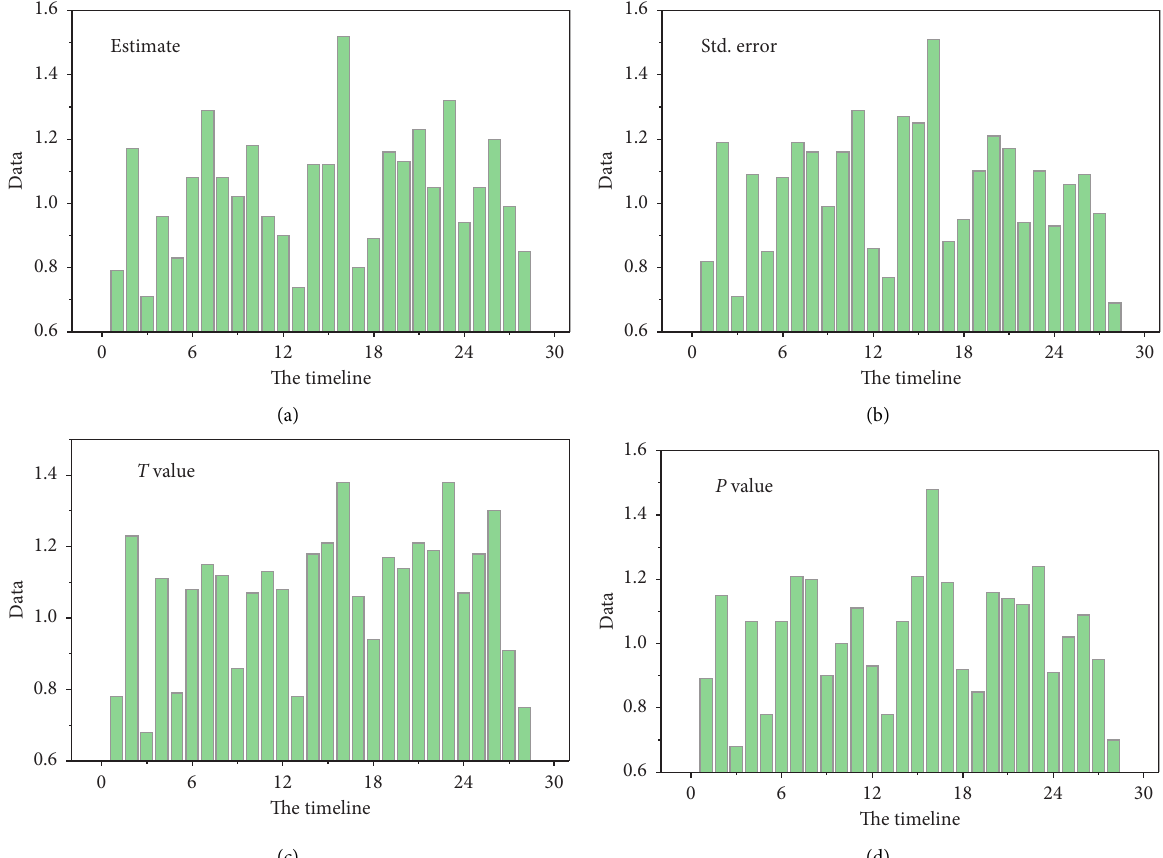
Figure 8: Results of logistic regression analysis of students’ English performance.